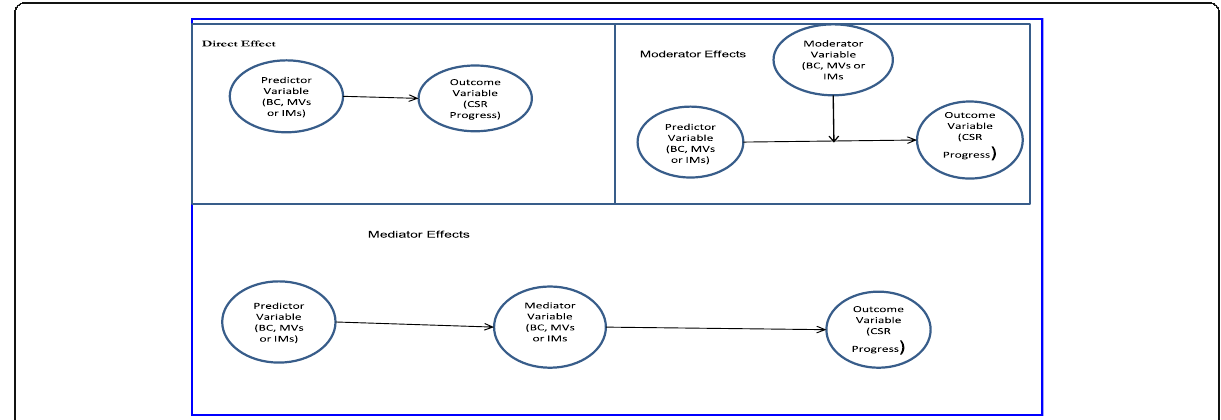
Fig. 2 Direct, Moderator and Mediator Effects between the proposed three mechanisms for CSR progress. Source: Author ’ s